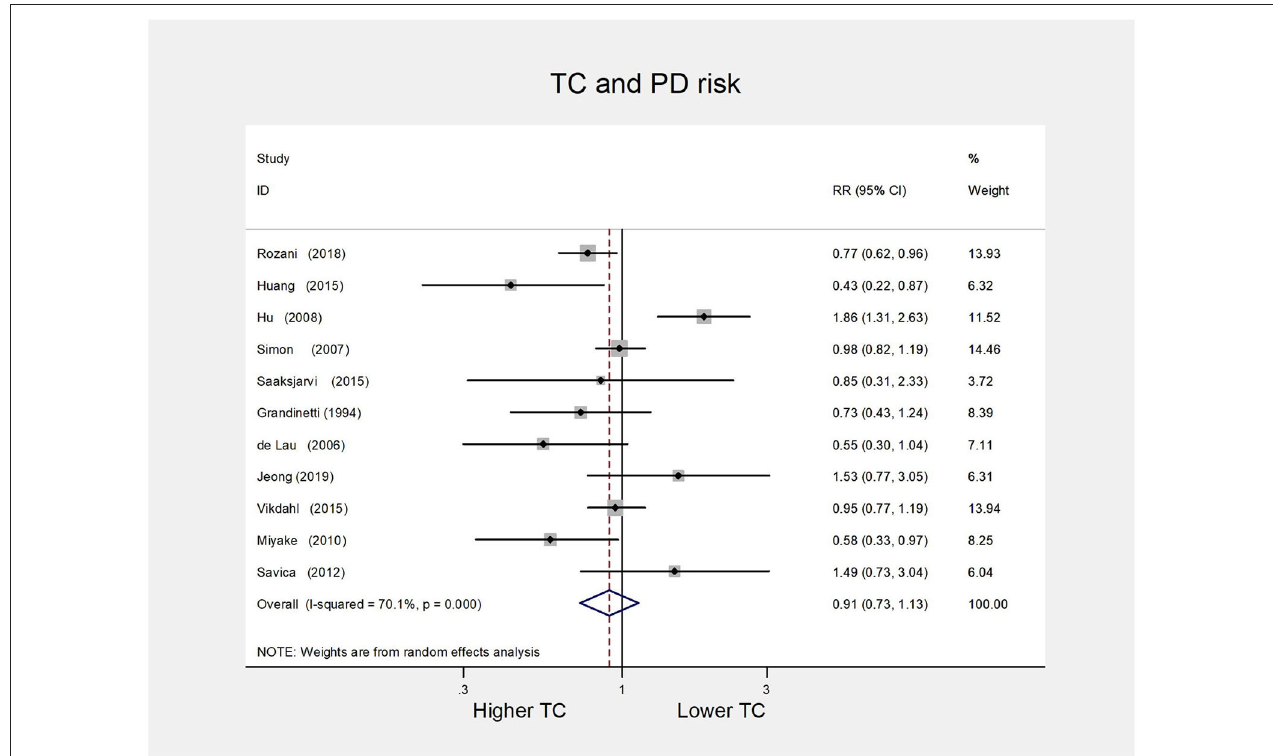
FIGURE 2 | Forest plot presenting the pooled estimate effects (RR) on the relationship between serum TC levels and risk of PD. RR, relative risk; CI, confidence interval; TC, total cholesterol; PD, Parkinson’s disease.